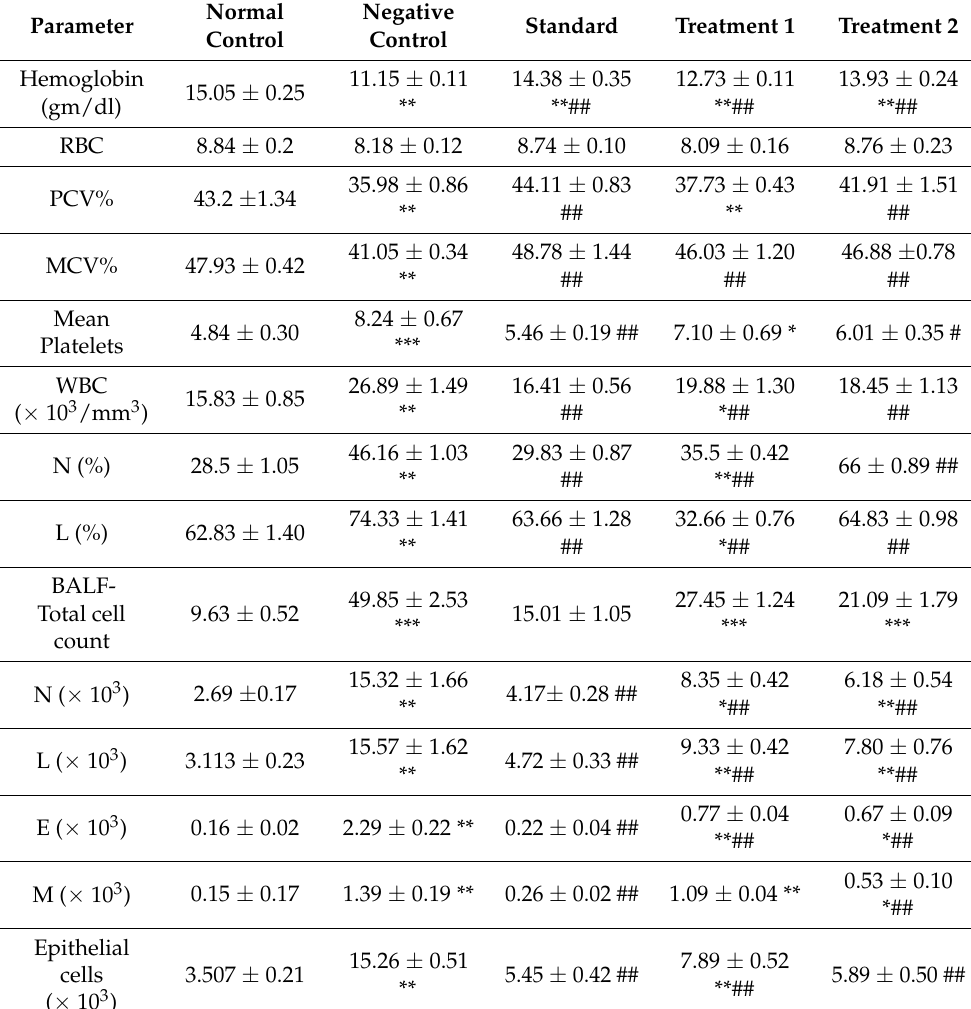
Table 2. Effect of treatment combination on OVA-induced alteration in hematological parameters and differential cell counts in BAL fluid of